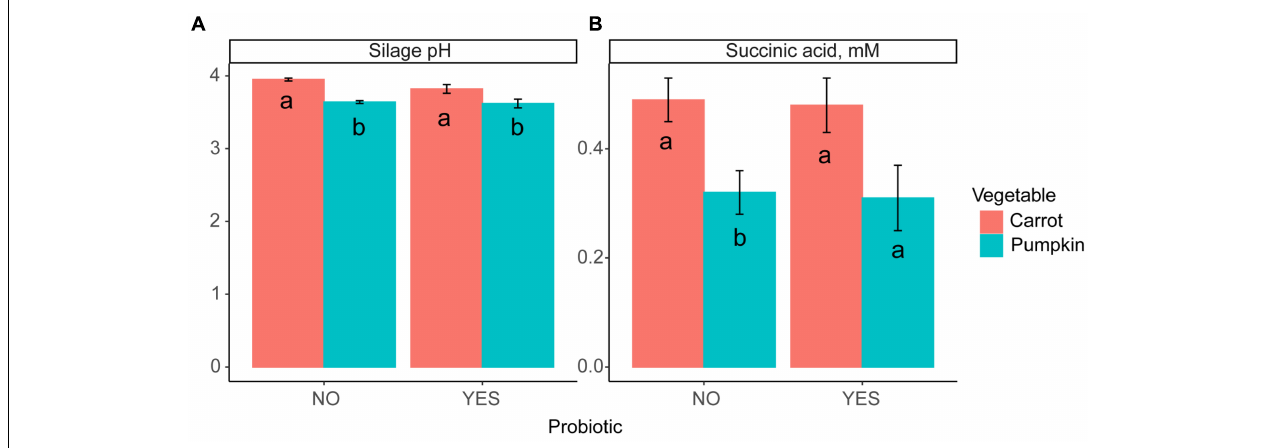
FIGURE 1 | A bar plot of (A) silage pH and (B) succinic acid concentration by vegetable ( P ≤ 0.02) inclusion with probiotic use. Letters a,b indicate differences ( P ≤ 0.04) between the probiotic